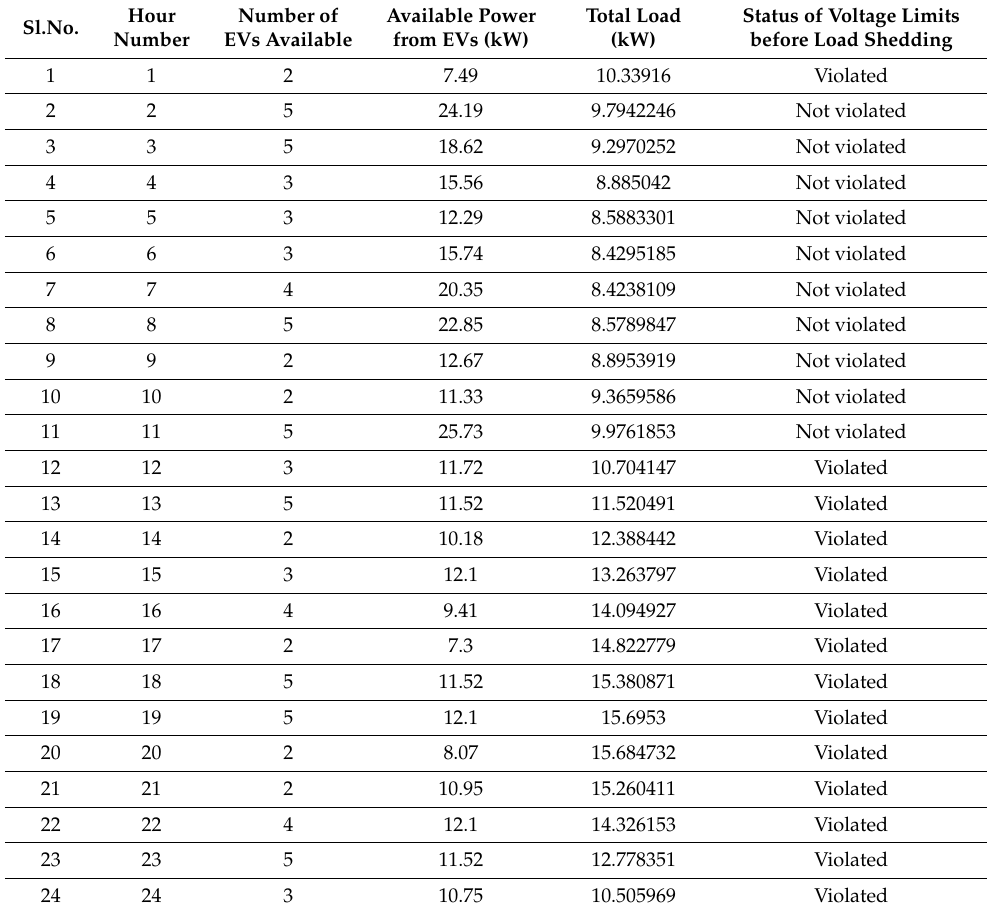
Table 3. Available number of EVs, power from EVs, total actual load, and status of voltage limits during each hour. Hour Number of Sl.No. Number EVs